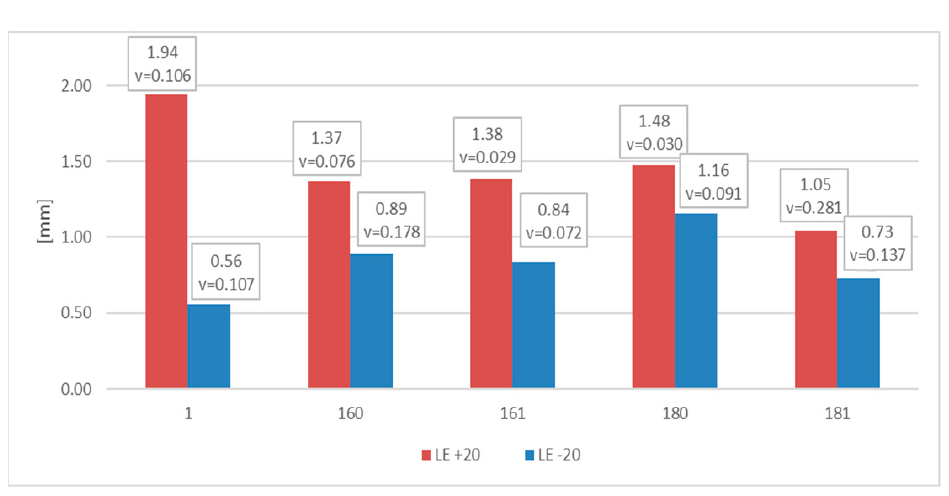
significant decrease in this energy. This means that under those conditions, the impact toughness of given material is much